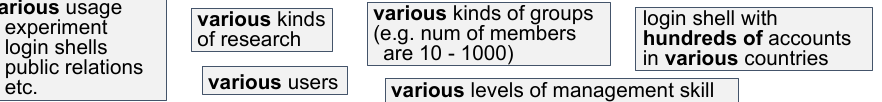
Figure 1: Various demands for DMZ hosts.